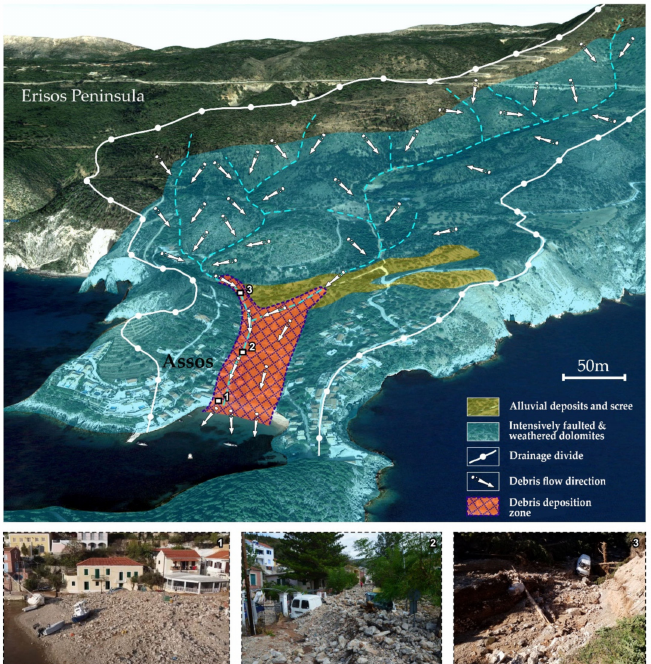
Figure 15. Schematic map of Assos village and Assos basin in the western part of Cephalonia Island, illustrating the basic geo-environmental parameters that contributed to the debris flow, as well as imagery from the basin’s outlet near the beach where the debris was largely